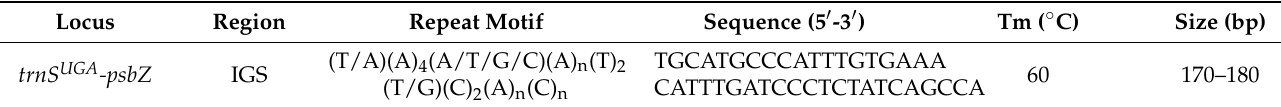
Table 3. Characteristics of the microsatellite marker used for HRM analysis.